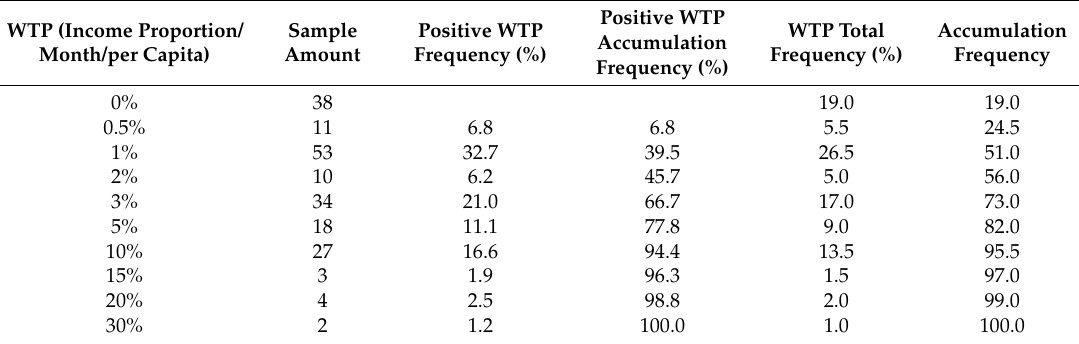
Table 2. Distribution of the WTP in terms of the bidding amounts regarding occupational safety and health